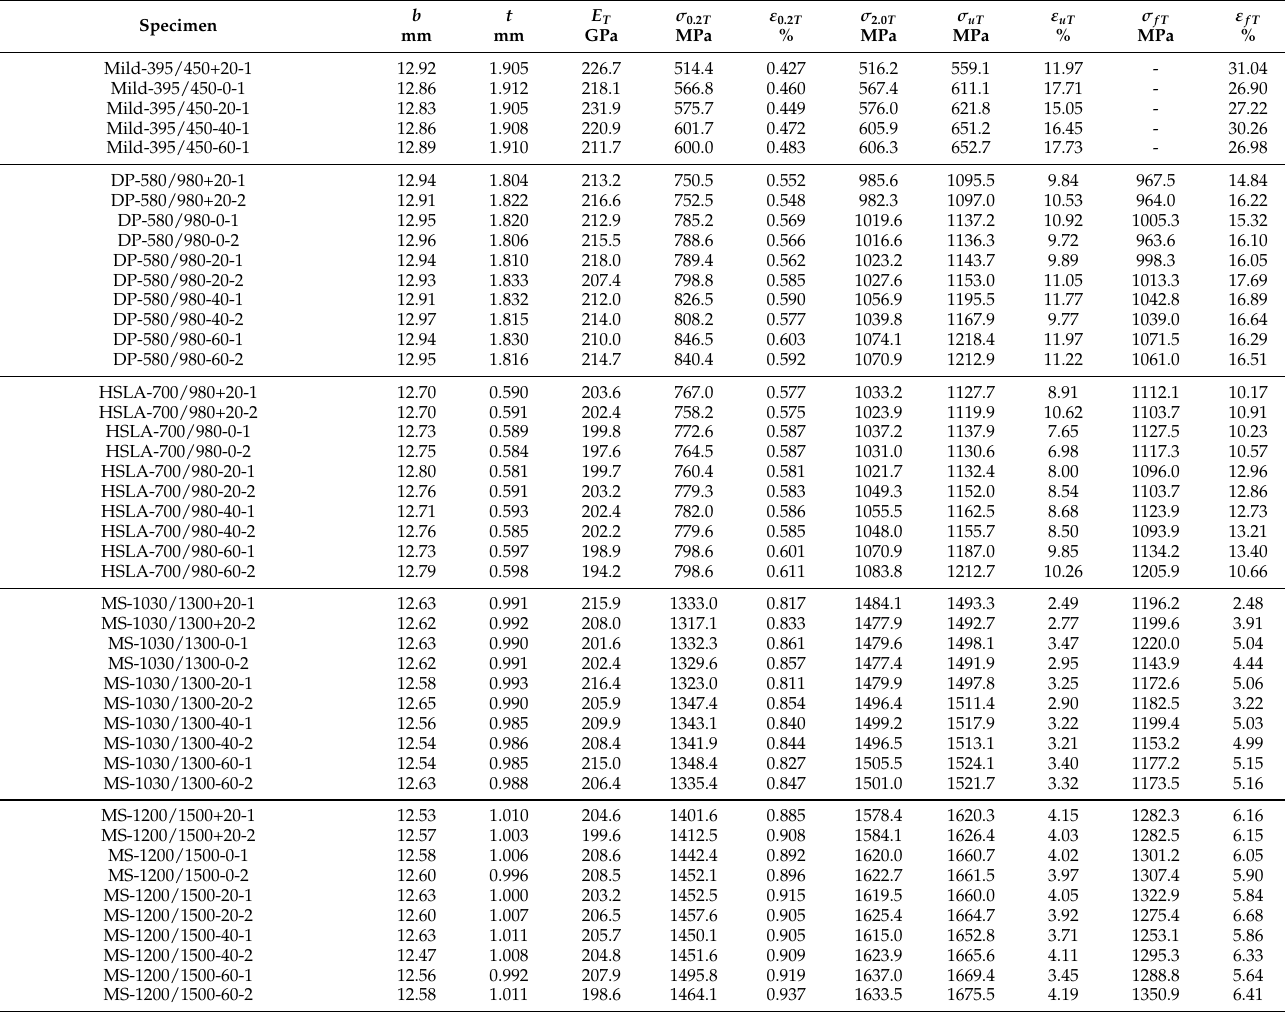
Table 3. Experimental properties of AHSS and conventional steel